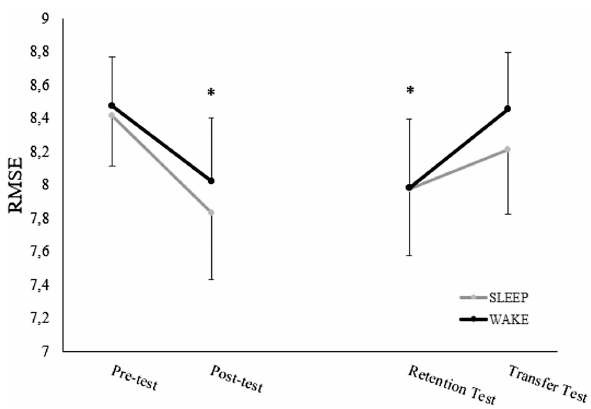
Figure 2 - Performance on the underarm dart-throwing task as assessed by root means square (RMSE) across practice, retention, and transfer period. Data are presented as mean and 95% confidence interval by each group. * = significant difference in Time factor in comparison to pre-test.